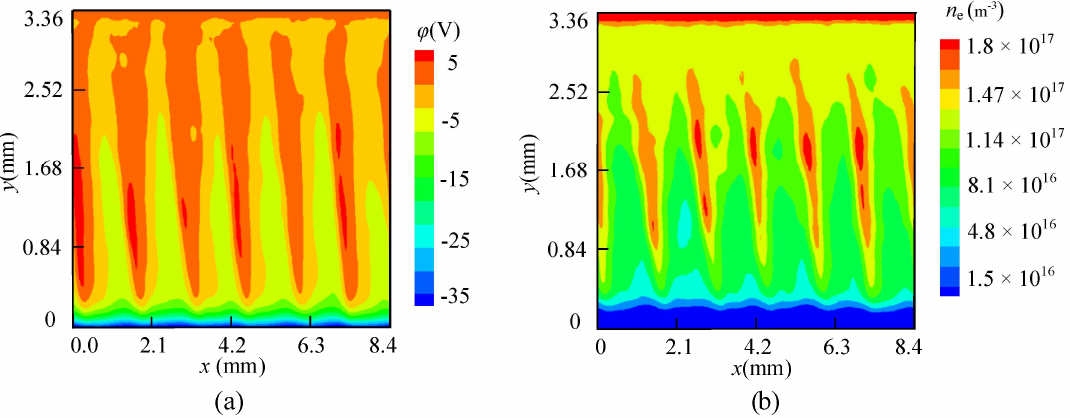
Figure 4. The 2D spatial distribution of ( a ) electric potential and ( b ) electron density with E ⊥ B .